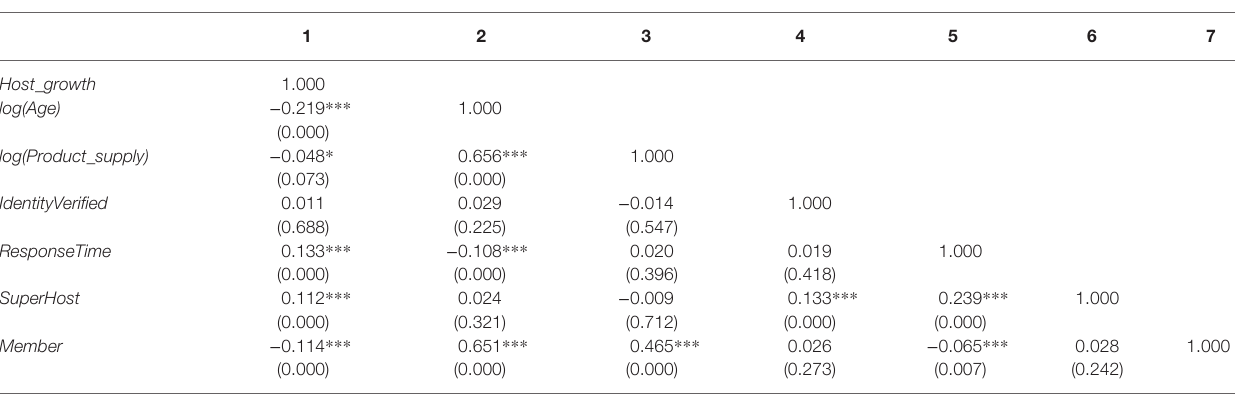
TABLE 2 | Correlation coefficient